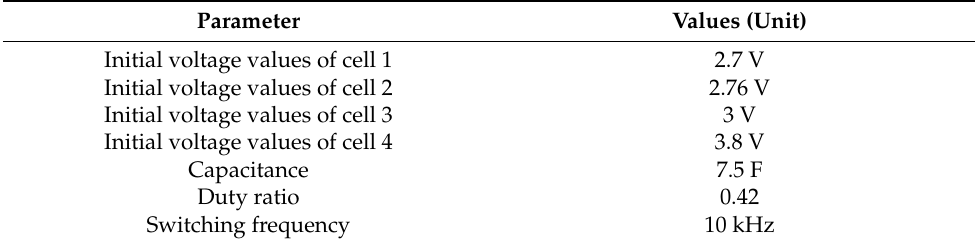
Figure 15. Test setup for experiment. ( a ) Overall setup, ( b ) Gerber file. Table 1. Circuit Parameters for Experiment. Table 1. Circuit Parameters for Experiment.